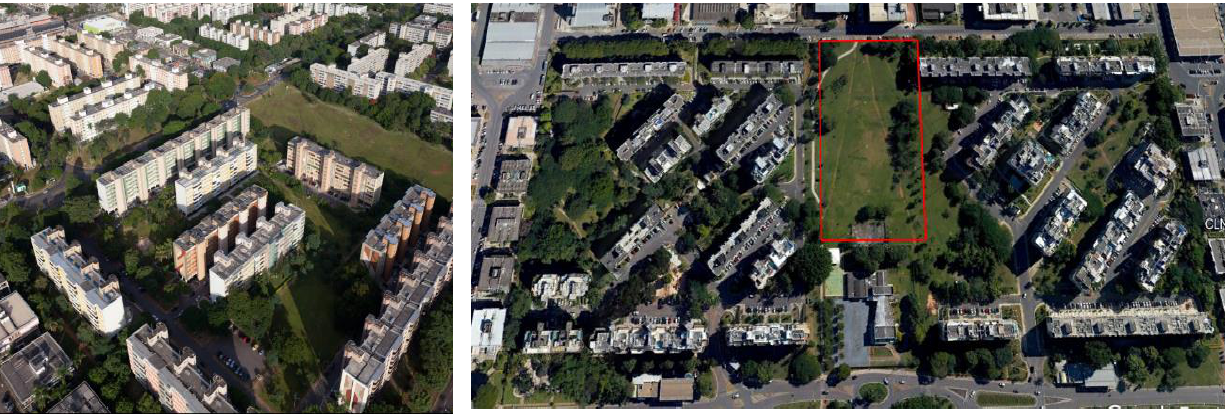
Figure 2 (left): Aerial view of a Superquadra with its inner green areas. The vast empty green area in between Superquadras is an Entrequadra. (Photo credit: Joana Franca,